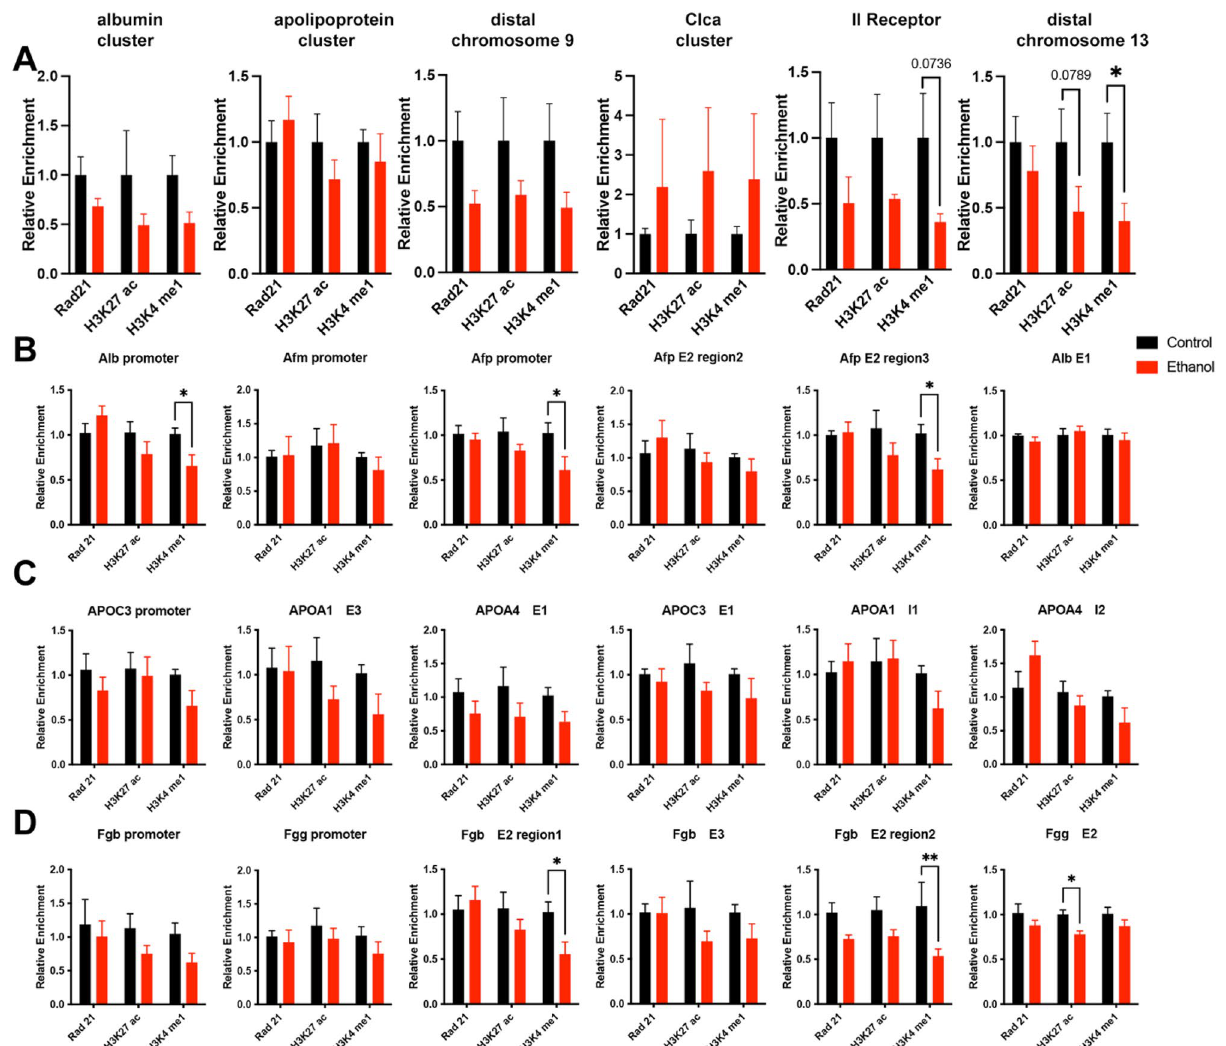
Figure 5. Consistent RAD21 binding and modest alterations in enhancer-associated histone posttranslational modifications in placentae derived from the male offspring of alcohol-exposed sires. We used ChIP qPCR to assay the enrichment of the cohesin component RAD21 and histone H3 lysine 27 acetylation (H3K27 ac) and lysine four mono-methylation (H3K4 me1) at ( A ) loci identified in our ChIP-seq analysis, as well as specific loci within the ( B ) albumin , ( C ) apolipoprotein , and ( D ) fibrinogen gene clusters identified in Fig. 4. We performed ChIP experiments on eight placentae from each treatment (n = 8), derived from five different litters, and used a two-way ANOVA followed by an Uncorrected Fisher’s LSD. Error bars represent the standard error of the mean, * P < 0.05, ** P < gene clusters display altered enrichment in placentae derived from the male offspring of ethanol-exposed males, which correlate with altered gene expression across the affected gene clusters. Alterations in placental CTCF occupancy do not correlate with changes in the cohesin complex member Rad21 or broad changes in enhancer-associated histone posttranslational modifica- tions. CTCF and the cohesin complex are required for chromatin looping 44 , a subset of which facilitates influence both cohesin localization and enhancer function. Using ChIP, we examined placental extracts for the enrichment of cohesin complex member RAD21 27 . In addition, we also examined the enrichment of the post- translational histone modifications histone H3, lysine four monomethylation (H3K4me1), and histone H3, lysine 27 acetylation (H3K27ac), given their association with poised and active gene enhancers, respectively 53 . Unexpectedly, using primers targeting the same candidate regions exhibiting altered CTCF enrichment identi- fied above, we did not observe any alterations in RAD21 binding, which was constant across all examined loci (Fig. 5). Further, only one region displayed a decrease in H3K27ac enrichment, while we observed reduced H3K4me1 at six out of the 24 (25%) loci examined (Fig. 5). From these data, we conclude that the altered CTCF